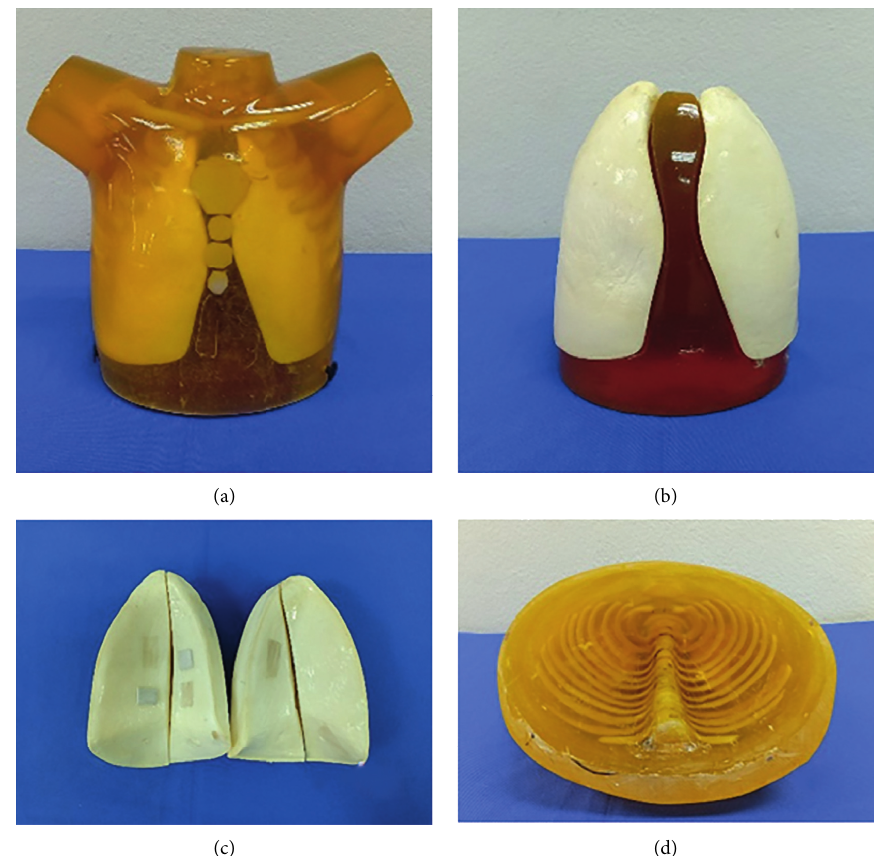
Figure 2: The constructed pediatric chest phantom: (a) the completed phantom; (b) the lung insertion part; (c) the left and right lungs; (d) the bone components (ribs and vertebra) in